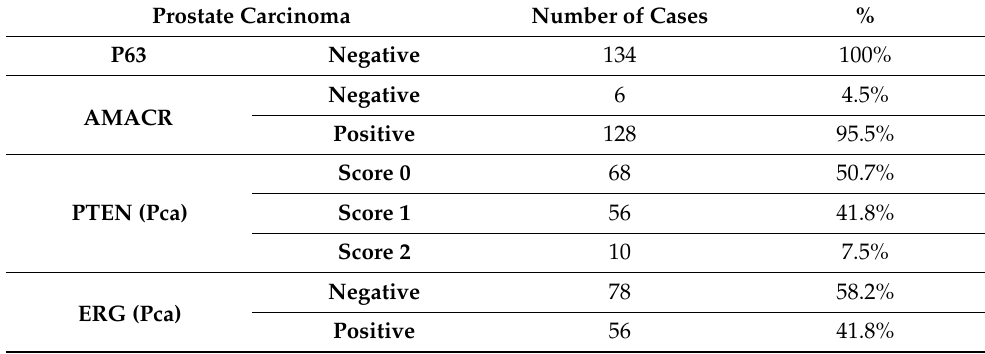
Table 2. Frequencies of study variables in our study with regard to prostate carcinoma. Prostate